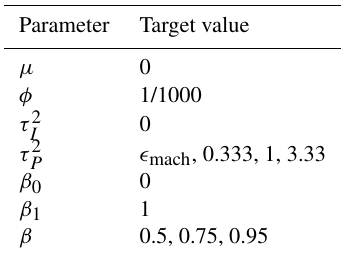
Table C2. List of parameter values defined for the target data set. The four values of τ 2 listed are related to the four different signal- P to-noise ratios: SNR = 1 . (cid:15) mach is machine epsilon, the smallest τ 2 P positive number represented by the